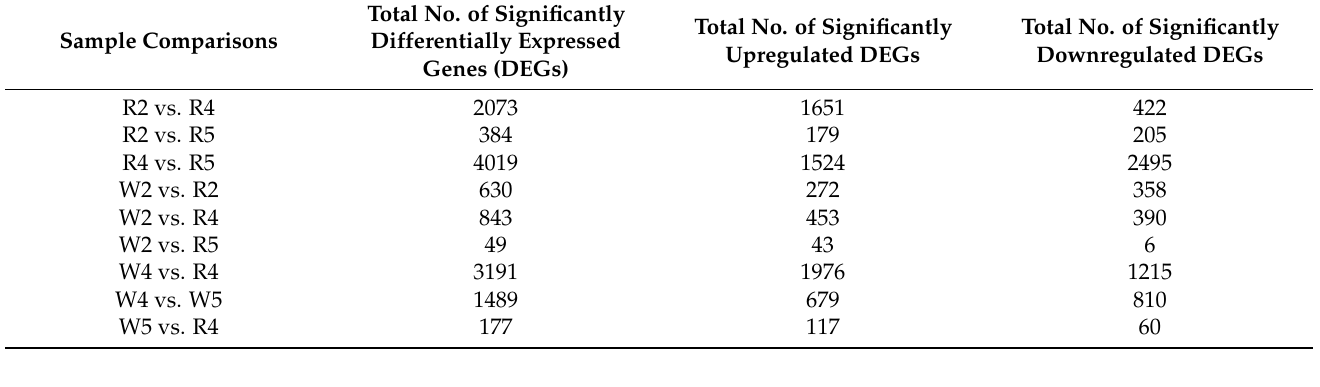
Table 1. DEGs in the different treatment groups.